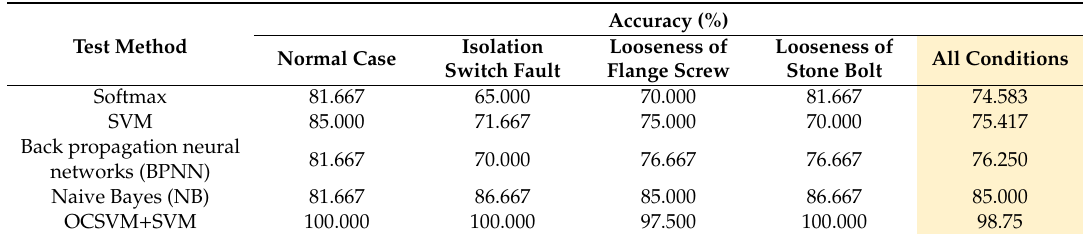
Table 4. Accuracy of the first experiment with di ff erent methods.